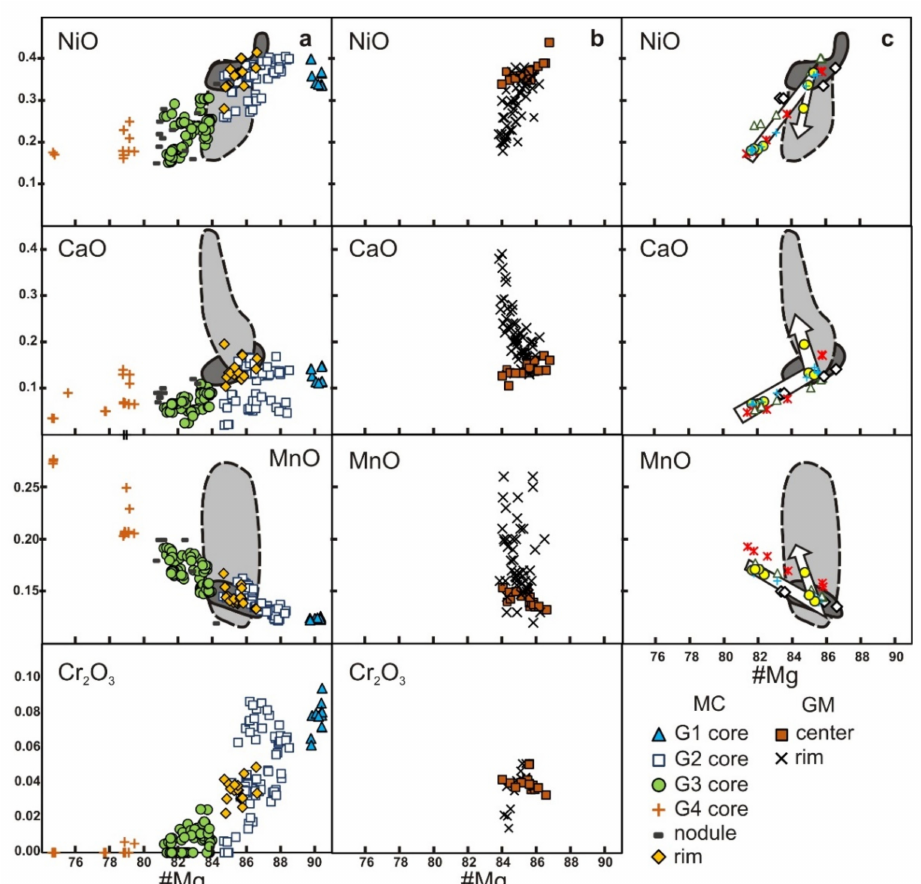
Figure 4. Compositional variations of olivines, Mg# vs. NiO, CaO, MnO, and Cr 2 O 3 (wt%). ( a ) Com- positions of different groups of macrocrysts (MC); ( b ) groundmass olivines (GM); ( c ) compositions of zonal macrocrysts ( G3 ), where the same symbols indicate the profile of one grain. The arrow shows the direction from core to rim, dark gray field—compositions of the central parts of groundmass olivines, light gray field—compositions of the rims of groundmass olivines, nodule—compositions of olivines from nodules.